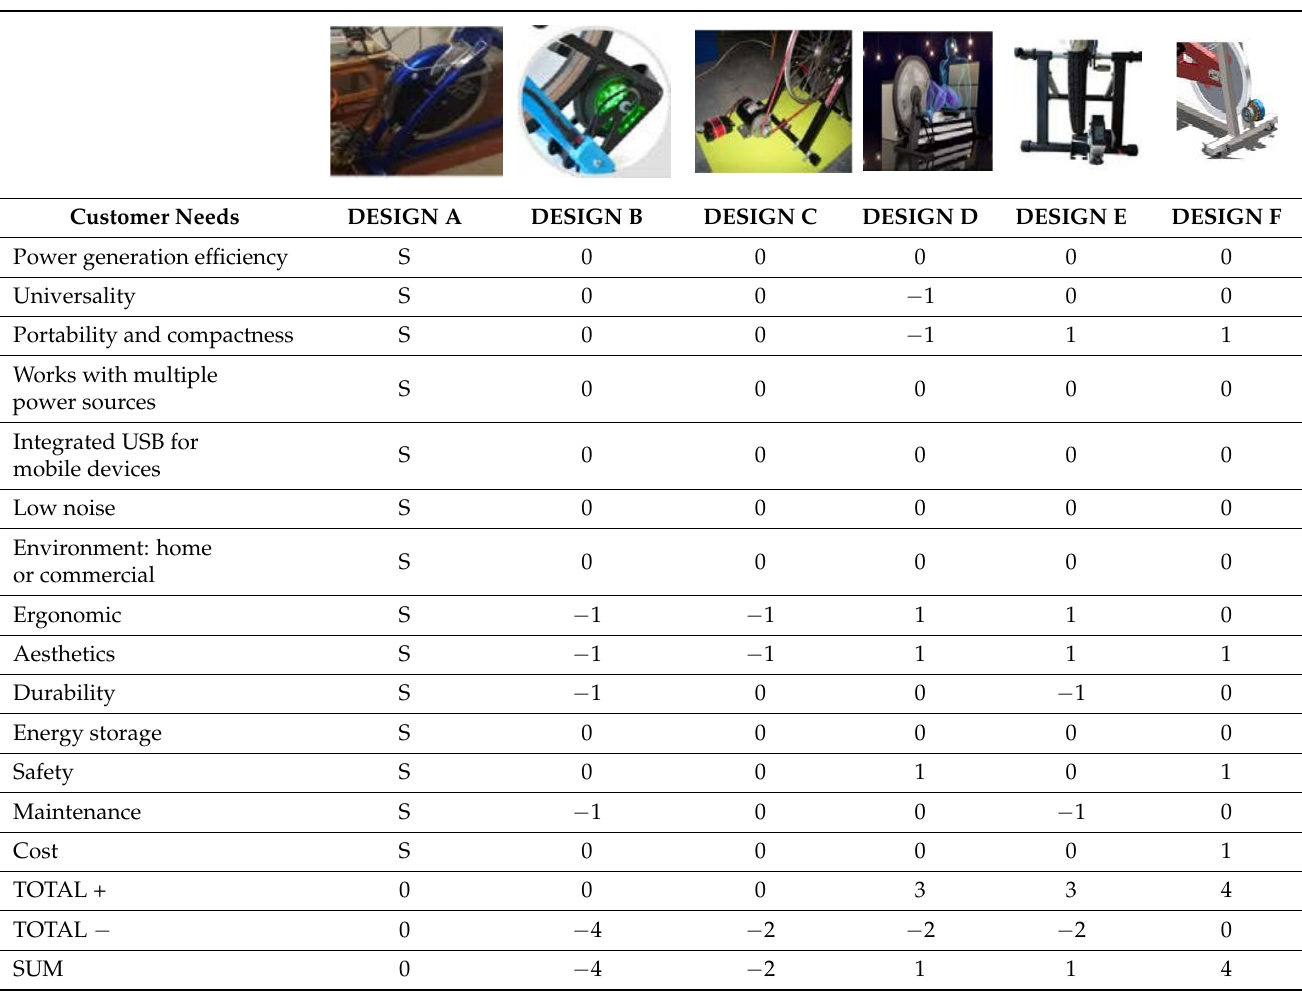
Table 1. A comparison of the energy harvesting subsystems of various designs in the literature. This method was used to select the best subsystems for our design.